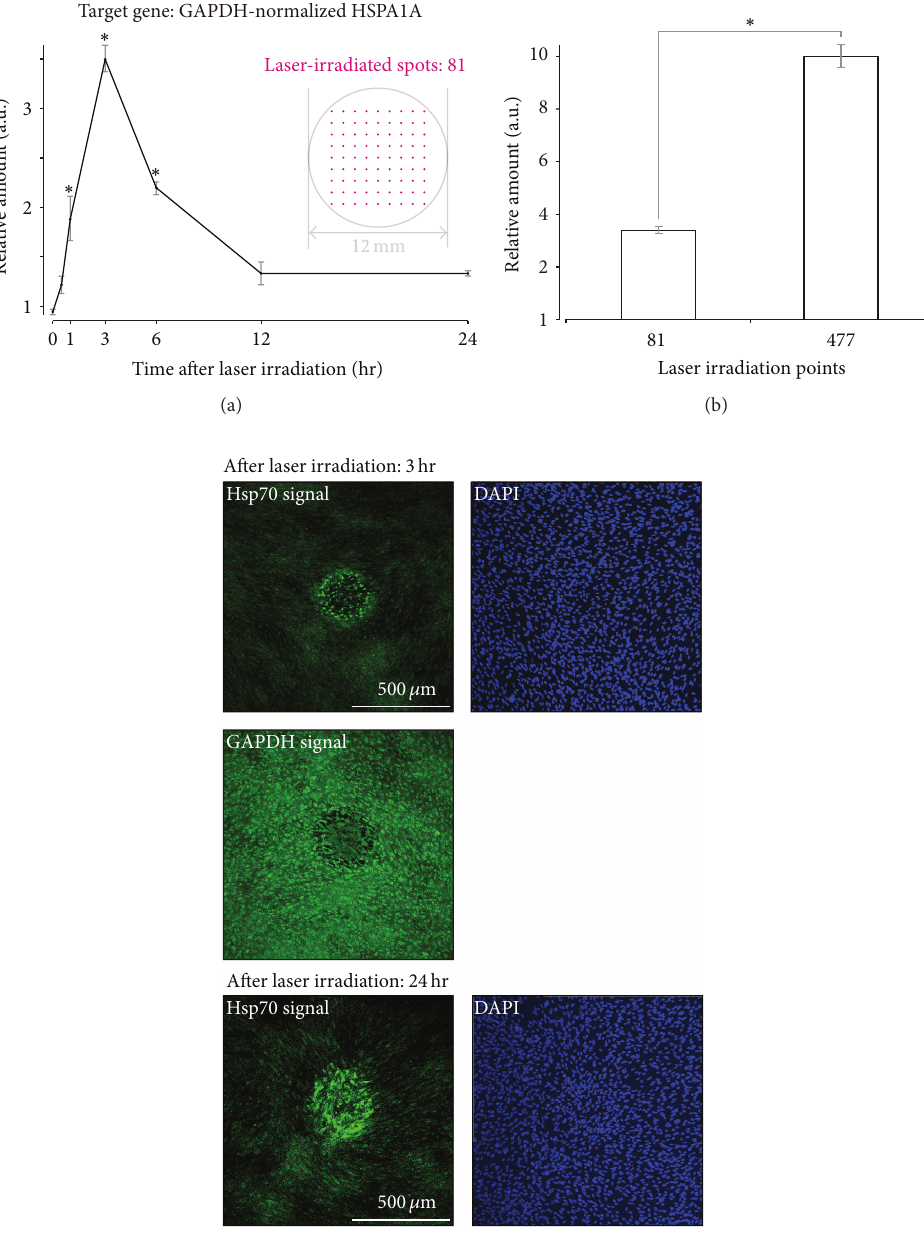
Figure 3: Changes in the expression of heat shock protein 70 (Hsp70) in cultured cell layers after sublethal photothermal stimulation. (a–c) Micropulse-mode laser irradiation sessions of cells on the glass-based dish were made using the following laser settings: 1000 ms exposure duration and 600 mW laser power. (a) Sublethal laser irradiation led to a transient upregulation of HSPA1A mRNA, which encodes the Hsp70 protein. At the indicated time points, total RNA was extracted, and HSPA1A mRNA levels were assessed using real-time quantitative reverse transcription polymerase chain reaction (qRT-PCR). GAPDH mRNA was used as an internal control. The data presented in the figure were normalized to the amount of HSPA1A mRNA in nonirradiated samples. Data represent mean values of three independent experiments. Error bars represent one standard deviation. The asterisk ( ∗ ) indicates statistical significance ( 𝑝 < 0.05 ), as determined using Student’s 𝑡 -tests. A schematic of the 81 laser irradiation spots on the cultured cell layer is shown in the insert. (b) Three hours following laser irradiation, HSPA1A mRNA upregulation was higher when 477 laser irradiation spots were made than when 81 spots were made. The asterisk ( ∗ ) indicates a statistically significant difference between means ( 𝑛 = 3 , Student’s 𝑡 -test, 𝑝 < 0.001 ). (c) Upregulation of Hsp70 protein at laser irradiation sites 3 h (upper and middle panels) and 24 h (lower panel) after sublethal photothermal stimulation. Cell layers were immunostained with the indicated antibodies and counterstained with 4 󸀠 ,6-diamidino-2-phenylindole (DAPI). Fluorescent images were captured with a confocal microscope (projected images). Immunofluorescent signals representing Hsp70 expression were detected around laser irradiation sites 24 h after laser irradiation (lower